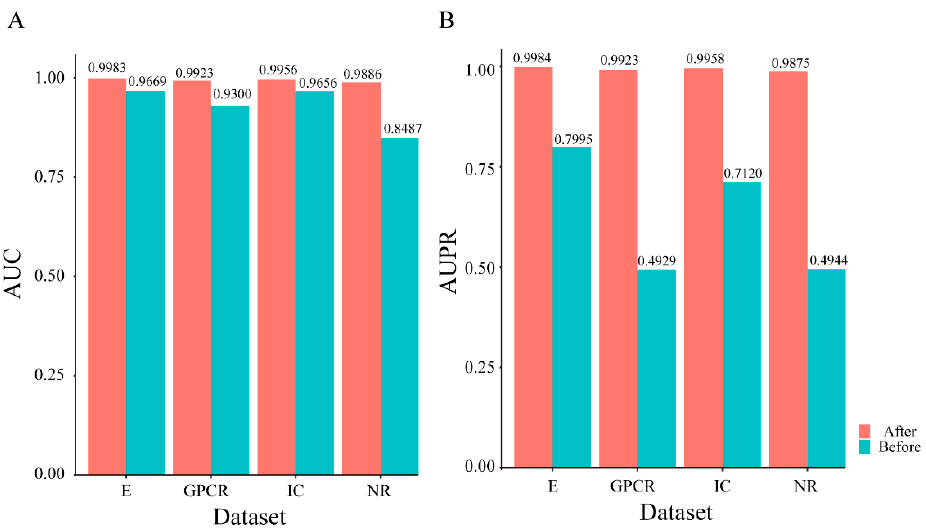
Figure 2. Predictive performance comparison of PsePDC-DTIs on benchmark datasets before and after SMOTE optimization in terms of AUC ( A ) and AUPR ( B ).